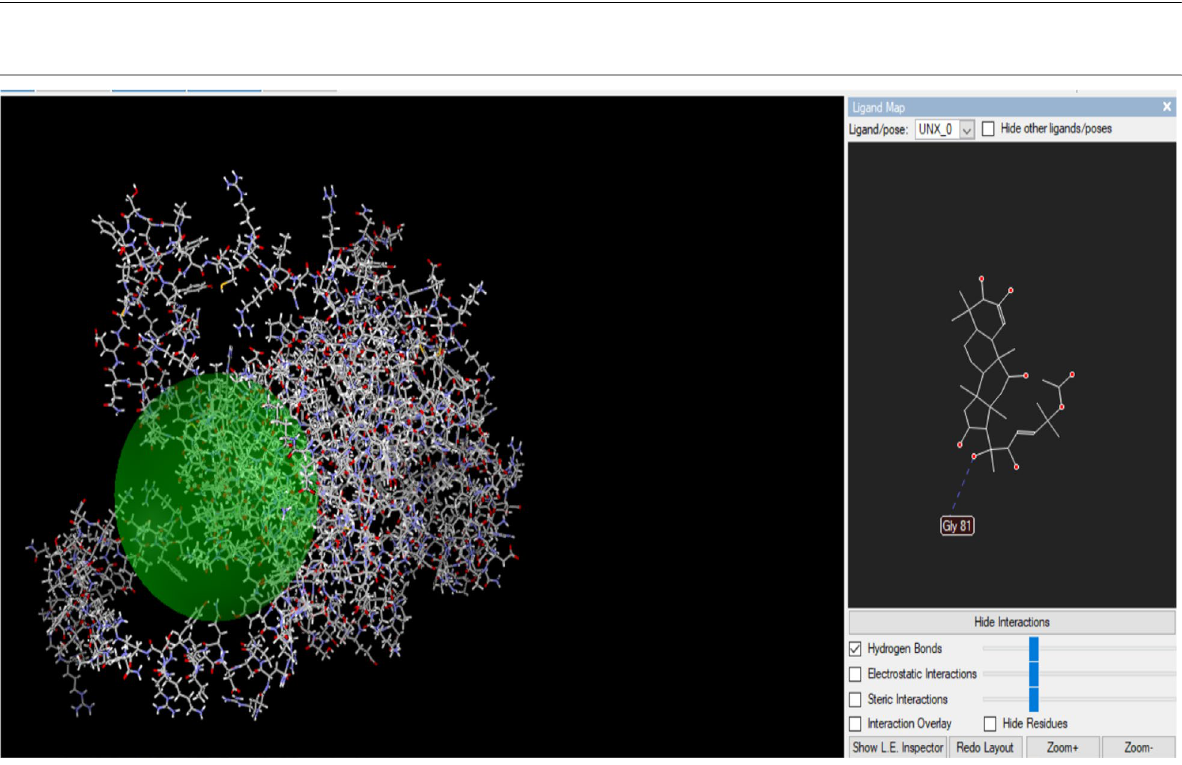
Fig. 15 The 3D representation of Cucurbitacin E at the active site of G. mellonella CAT enzyme (Hydrogen bond; Gly